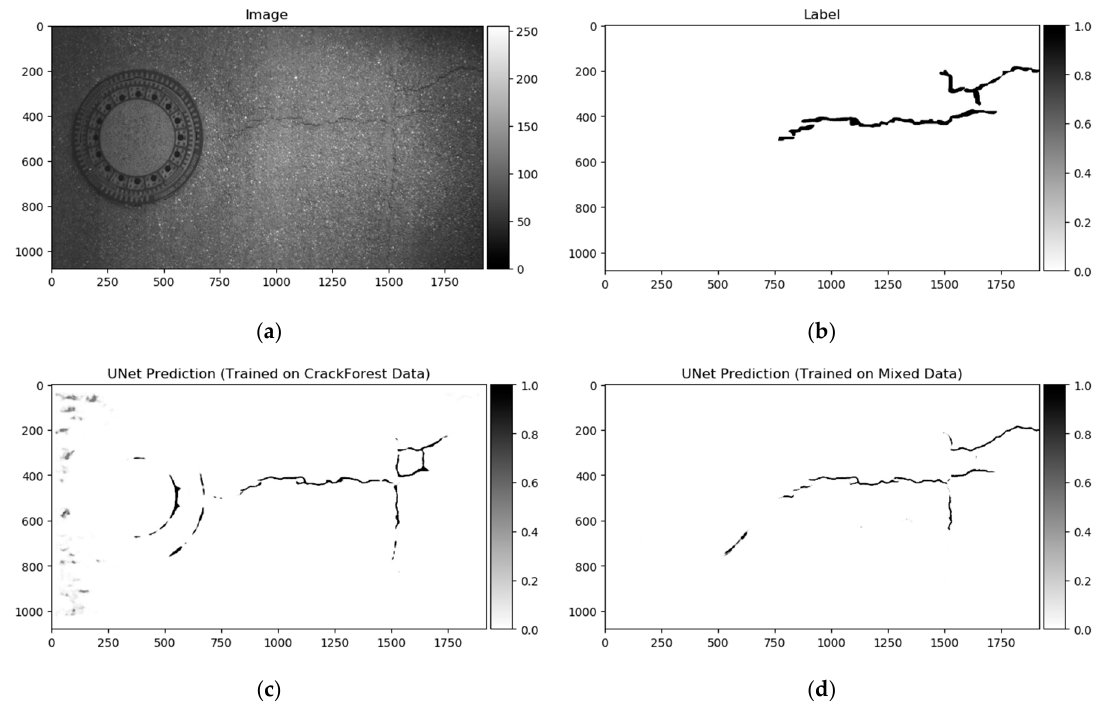
Figure 11. Prediction on the test sample from the GAPs384 dataset. ( a ) Image; ( b ) ground truth; ( c ) full prediction output of the model trained with the CrackForest dataset; ( d ) full prediction output of the model trained with the mixed dataset.